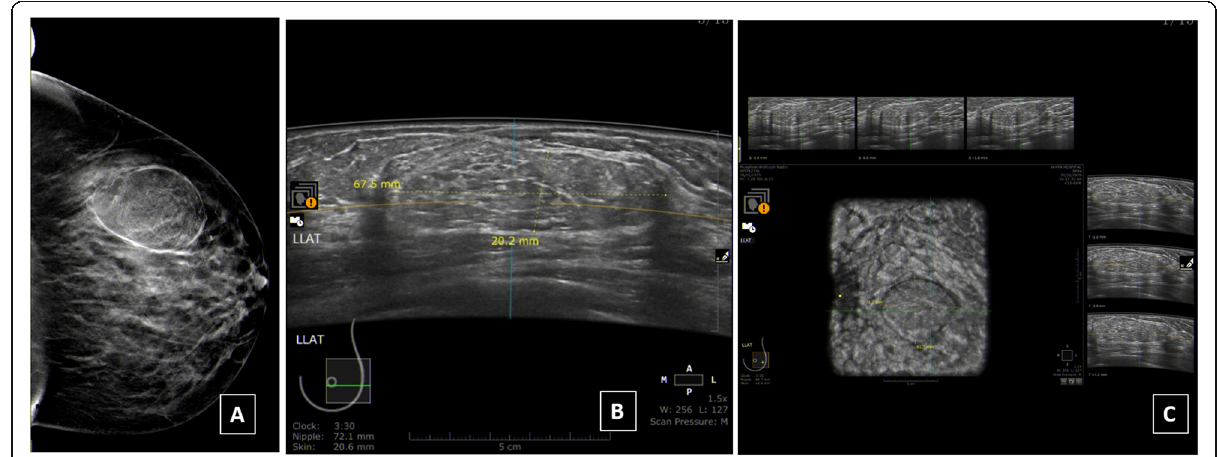
Fig. 2 Case two: 45-year-old female with enlarging left breast. A Tomo CC slice showing a well-defined lucent mass with a thick capsule (arrow). B , C ABUS images in transverse and multiplanar views showing the mass to be isoechoic with internal echogenicities and a surrounding echogenic capsule. Surgical excision revealed